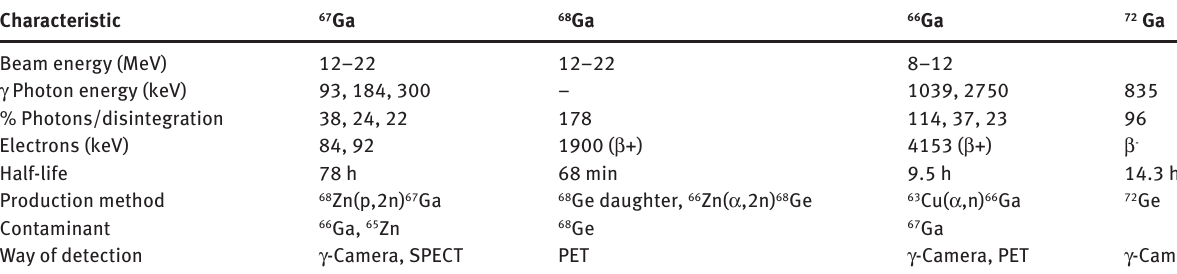
Table 1 Nuclear characteristics of Ga isotopes (Brucer et al., 1953; Welch and Redvanly, 2003).